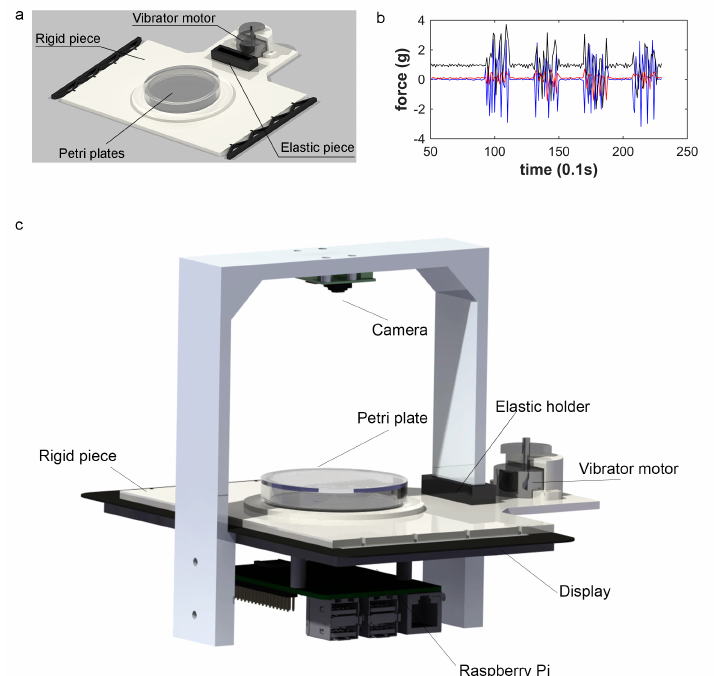
Figure 2. Vibrator system ( a ) Vibration system parts. ( b ) In our study, a Petri plate mounted on the rigid component was subjected to vibrations of between 2 g and 3 g on the X axis and the Z axis, and between 1 g and 2 g on the Y axis, when the vibrator motor was fed 12 V for 3 s time periods. The measurements were taken by an Inertial Measurement Unit (IMU) GY-521, recording the values shown in ( b ) (pallet vibration intensity). ( c ) Assembled altogether: vibration system adapted and the lifespan machine